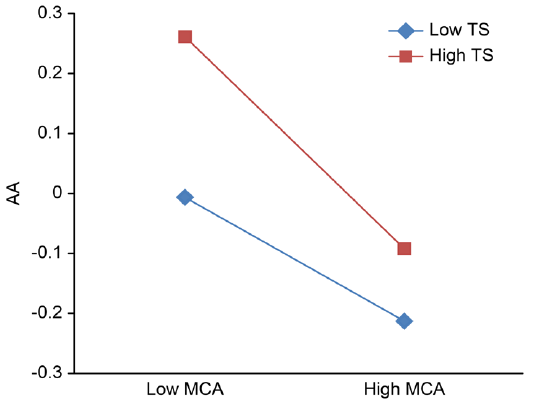
Figure 3. Teacher support adjustment chart b. MCA, mother-adolescent attachment; TS, teacher support; AA, adolescent anxiety.